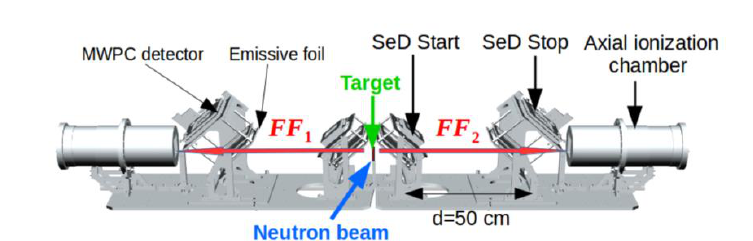
Fig. 1. Sketch of the FALSTAFF spectrometer (see text for